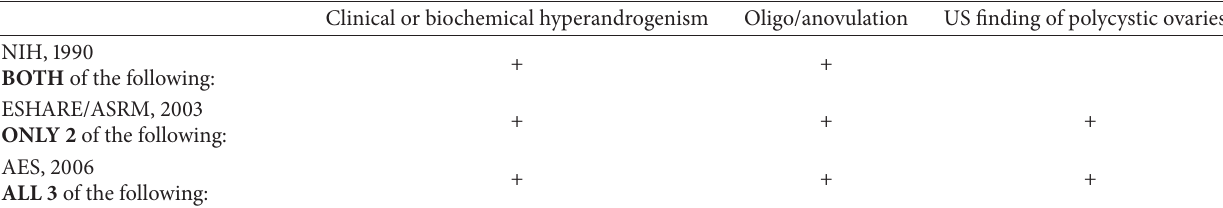
Table 1: Diagnostic criteria for Polycystic Ovary